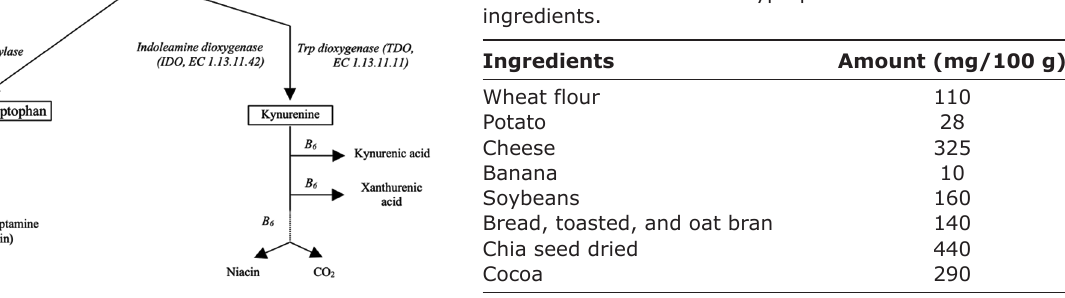
Figure-2: Overview of Tryptophan metabolism [4].